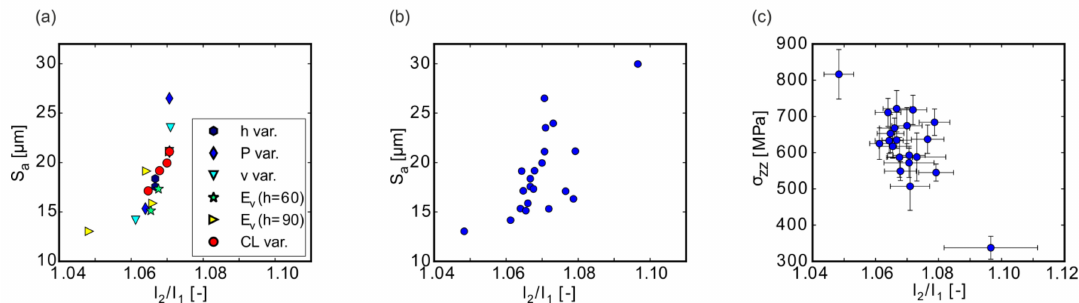
Figure 15. ( a ) Correlation of S a with I 2 / I 1 for specimens, which were manufactured with contour lines and the standard scan order CL(O-I)-V. The following samples are depicted: hatch distance variation (h var.), Section 3.4. ( c ); laser power variation (P. var), Section 3.4. ( a ); velocity variation (v var.), Section 3.4. ( b ); samples from the studies with hatch distances of 60 µ m and = 90 µ m at E V = const. (h = 60 µ m and h = 90 µ m), Section 3.5; samples from the contour line (CL var), Section 3.3. ( b ) Correlation of S a with I 2 / I 1 for all specimens. ( c ) Correlation of the residual stress in build direction / I σ zz with I 2 1